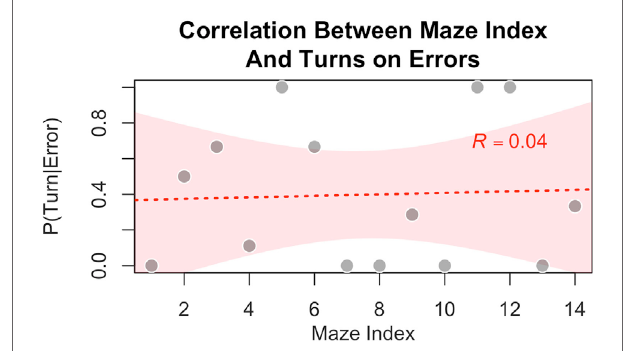
FigUre 10 | Participants showed no tendency to commit more errors on turns (as opposed to continuation in the same direction) in the experimental condition as a function of increasing experience with mazes, suggesting that subjects were not relying on a learned strategy of persevering in the same direction (instead of deciding at random) when the stimulation resulted in an ambiguous percept